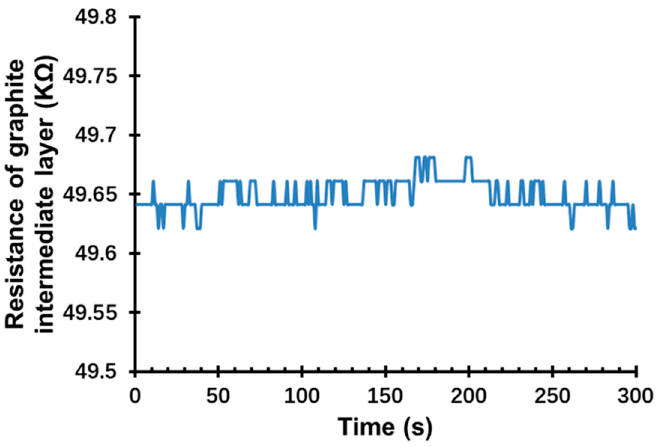
Figure 4. Changes in the resistance of the graphite intermediate layer when exposed to 10,000 ppm H 2 .